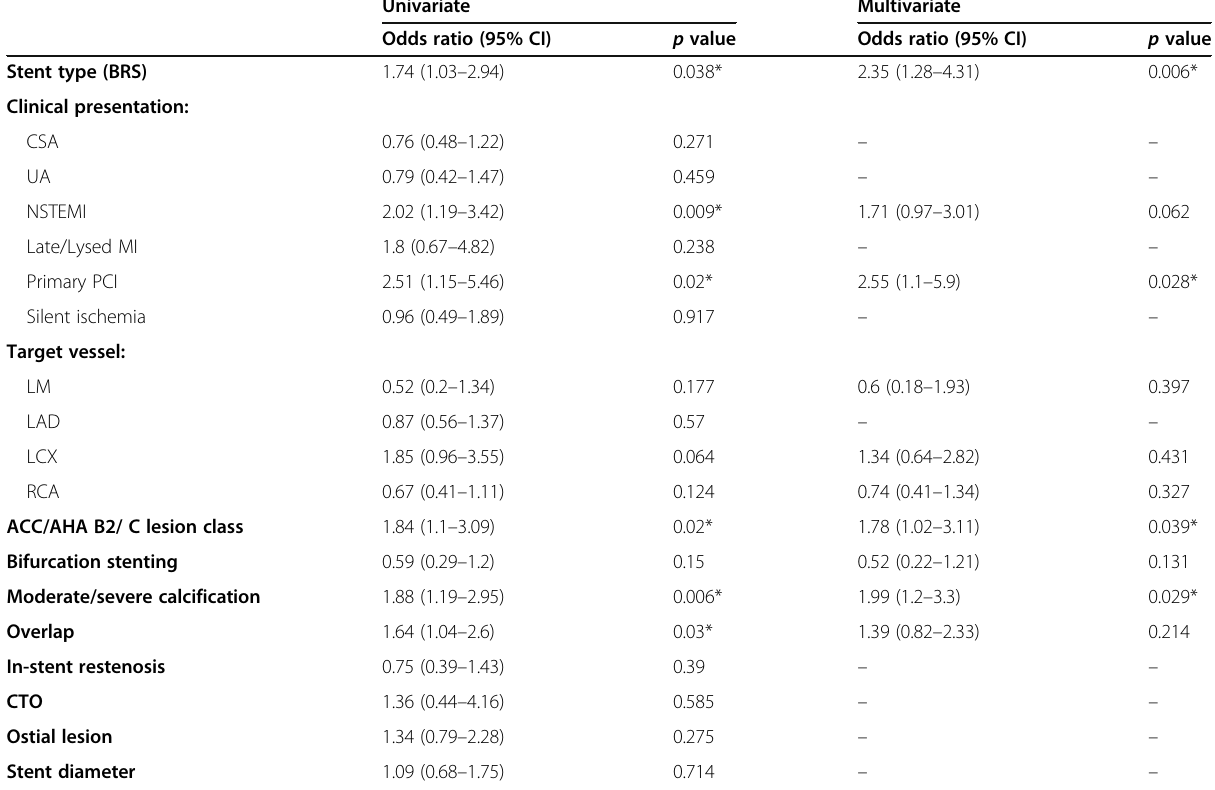
Table 5 Multivariate logistic regression analysis of OCT-based modification in the studied population Univariate